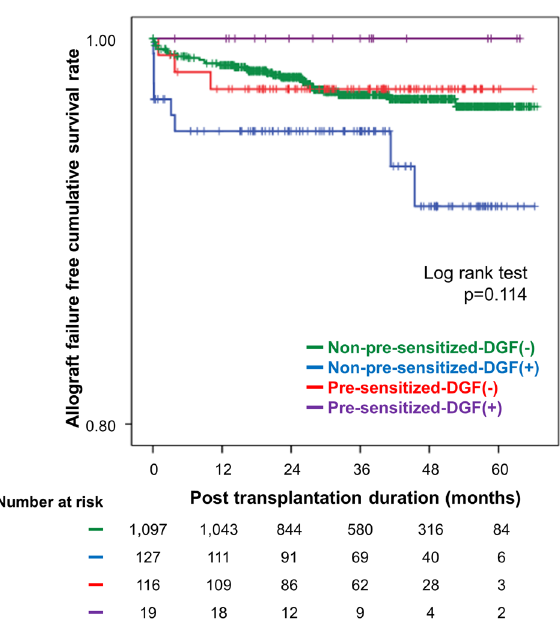
Figure 3. Kaplan–Meier estimates of death-censored allograft survival according to DGF and pre-sensitization status. The numbers below the figures denote the number of KTRs at risk in each subgroup. DGF delayed graft function, KTR kidney transplantation